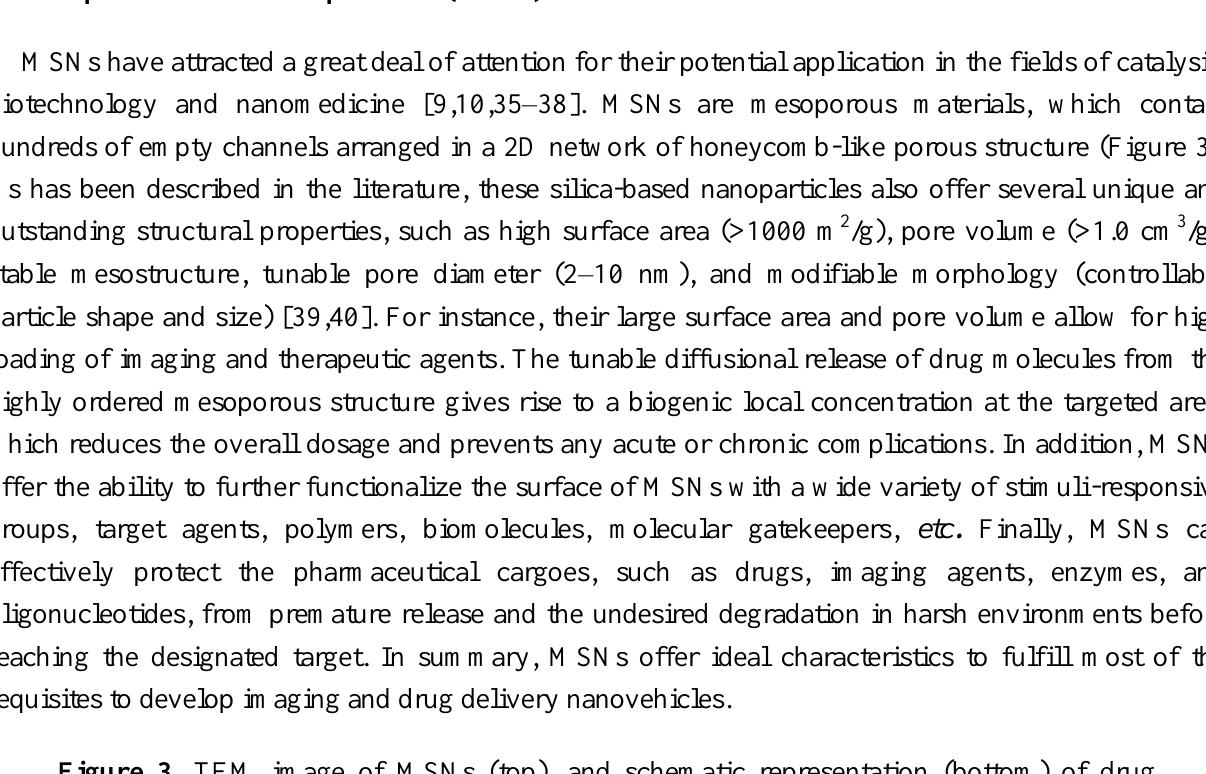
Figure 3. TEM image of MSNs (top), and schematic representation (bottom) of drug delivery from the same material. The release of the therapeutic agent can be triggered by different stimuli-responsive strategies (pH, redox potential, temperature, light, ultrasound and magnetic